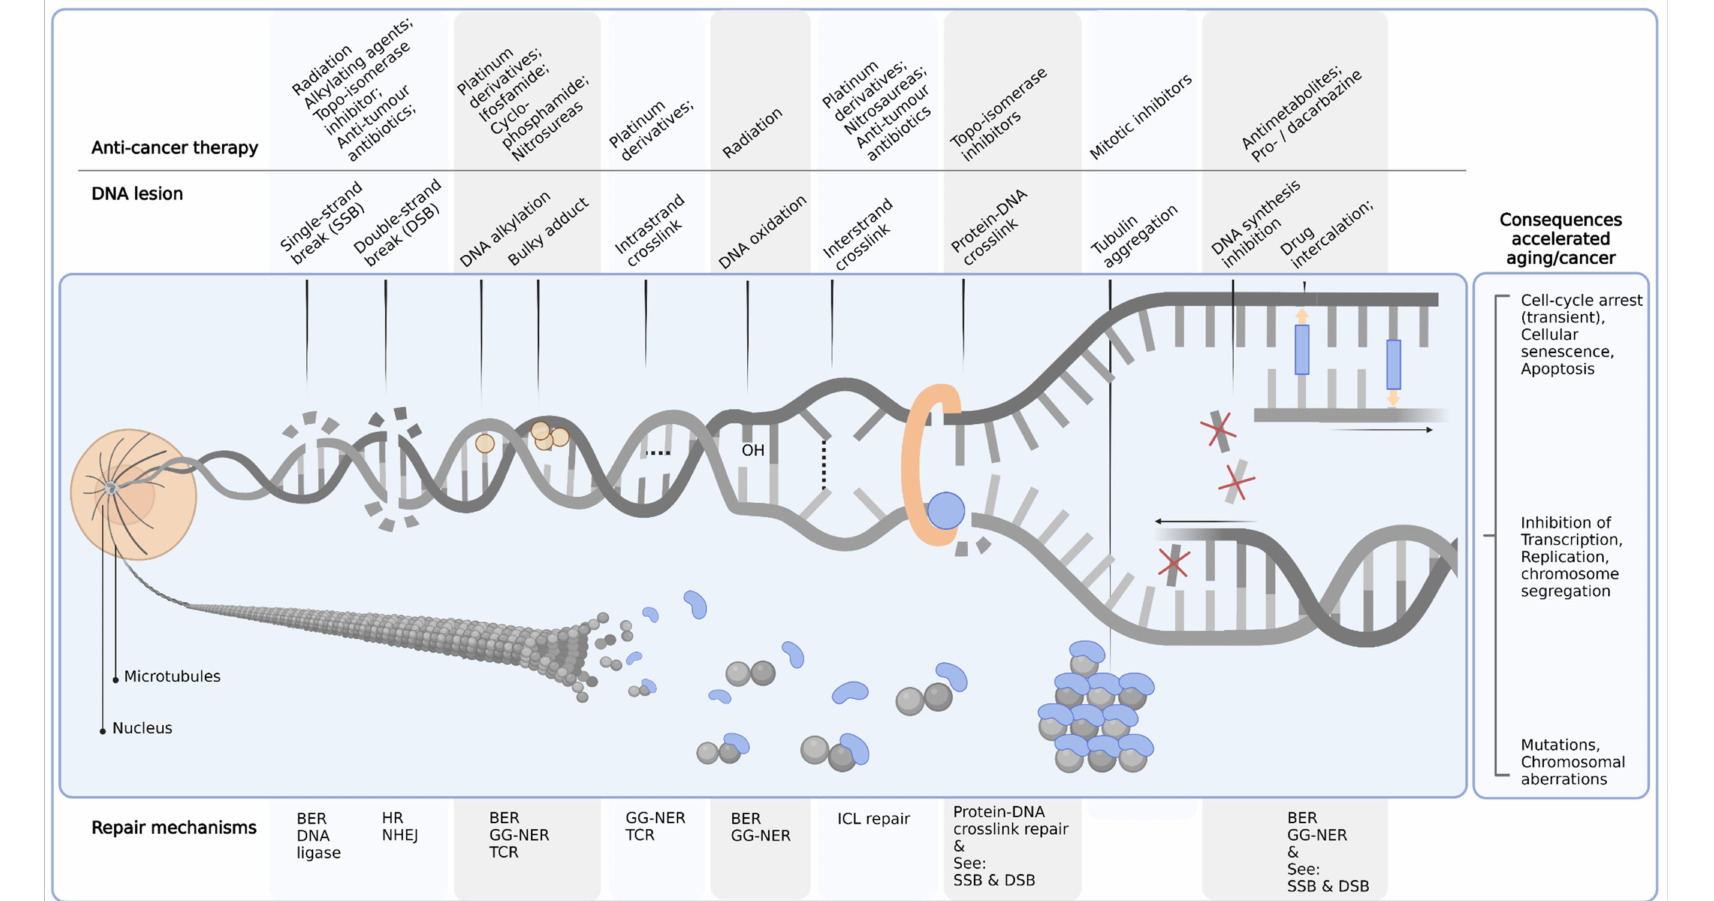
Figure 1. Chemotherapeutics, DNA damage, repair mechanisms, and consequences. Examples of commonly used anti-cancer treatments interfering with DNA metabolism ( top ); DNA lesions induced by these anti-cancer agents ( middle ); relevant DNA repair processes responsible for the removal of the lesions (bottom) and consequences of persisting DNA lesions accelerating aging and/or secondary cancers ( right ). BER, base excision repair; GG-NER, global genome-nucleotide excision repair; HR, homologous recombination; NHEJ, non-homologous end joining; TCR, transcription-coupled repair; ICL, interstrand crosslink; SSB, single-strand break; DSB, double-strand